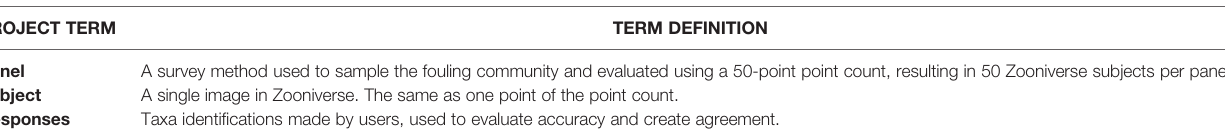
TABLE 1 | A record of Invader ID and Zooniverse speci fi c terms with their de fi